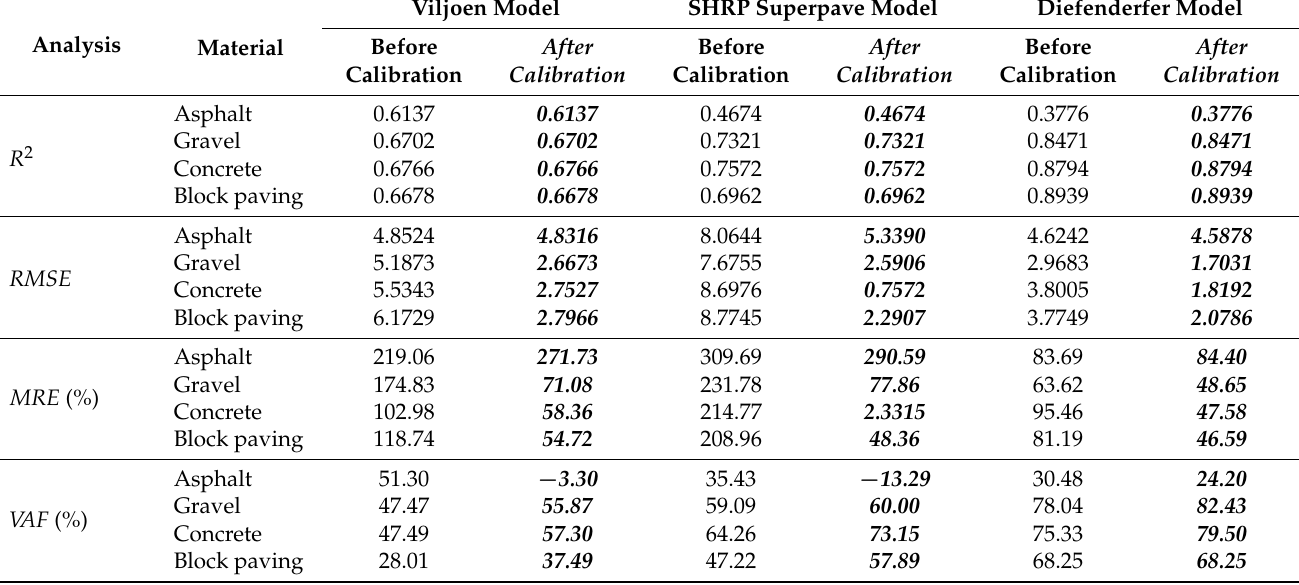
Table 2. Analysis of predicted minimum